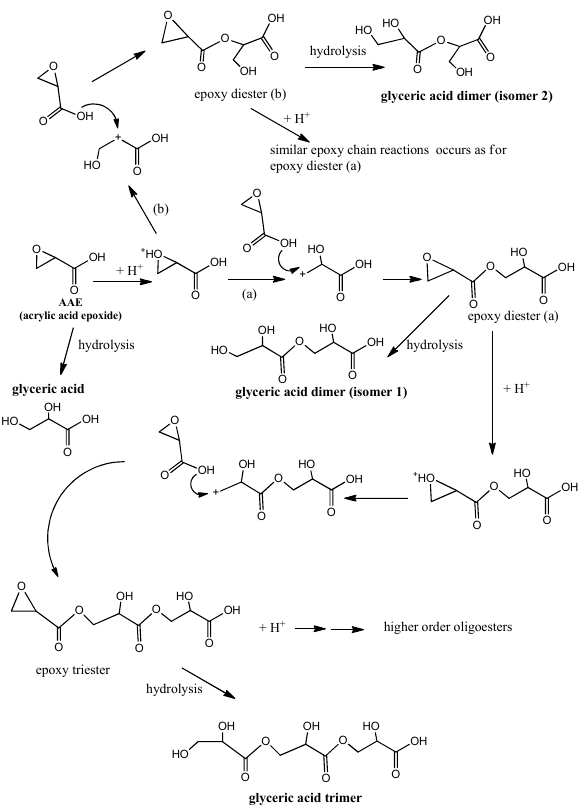
Scheme 3. Proposed mechanism for AAE oligomerization via epoxy chain reactions leading to glyceric acid, and glyceric acid oligoesters 8 The detection in the aerosol phase of a series of oligoesters with structure characteristics 10 of a combination of an alcohol and an acid compound (Table 2), suggests that reactions in the